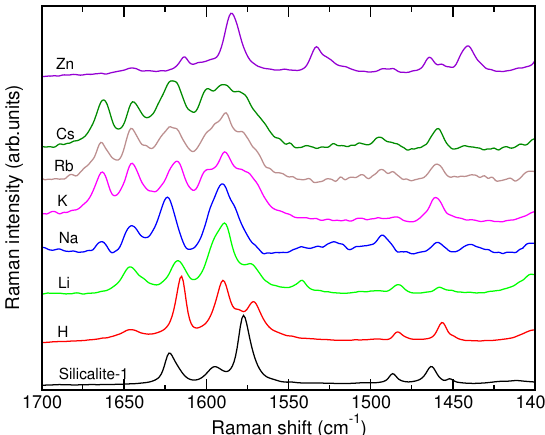
Figure 3. Experimental off-resonance Raman spectra of SA@M-ZSM-5 samples.